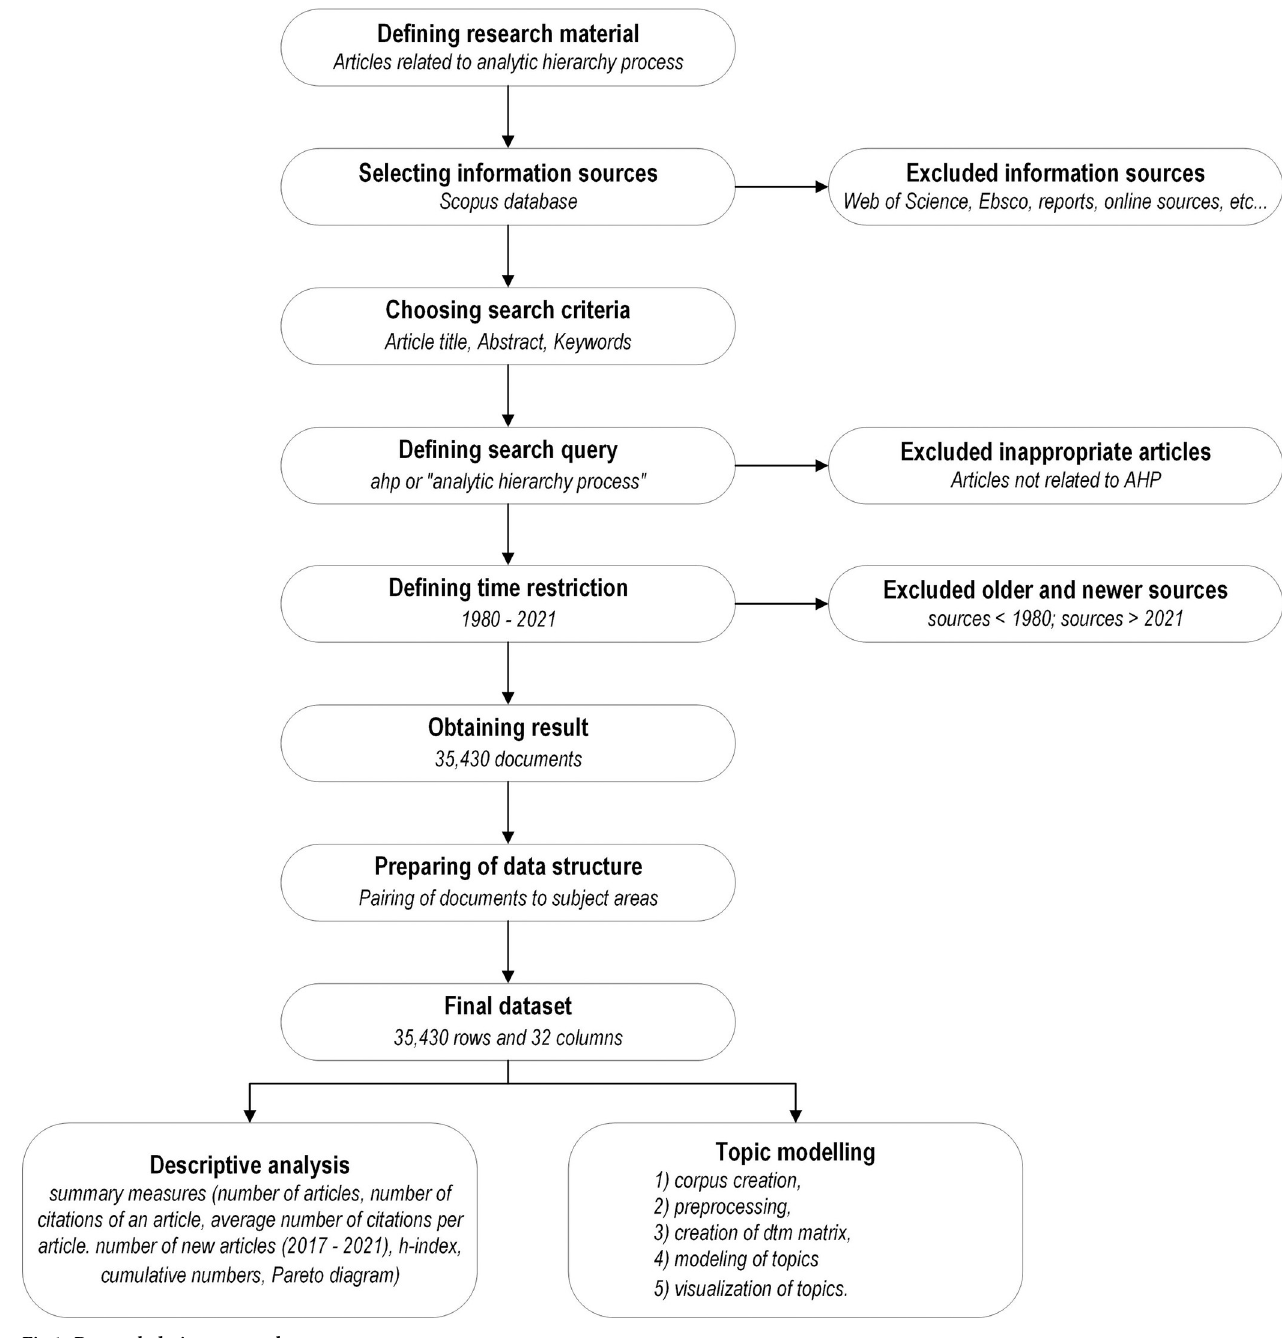
Fig 1. Research design